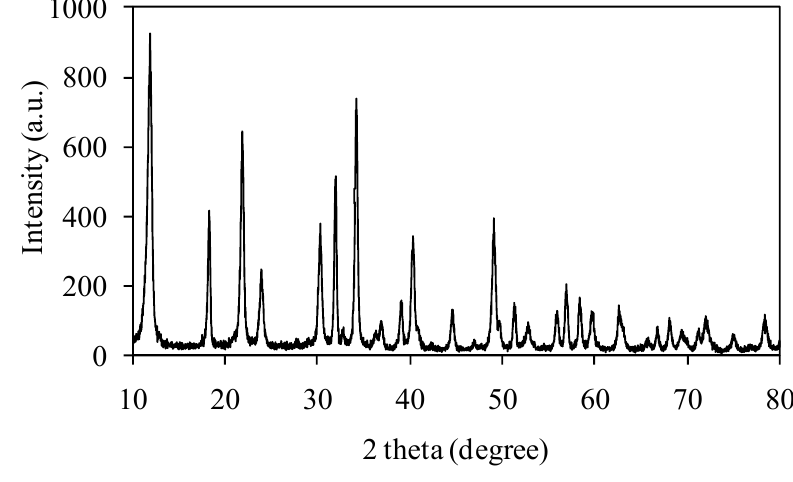
Figure 2. XRD pattern of the used NaBiO